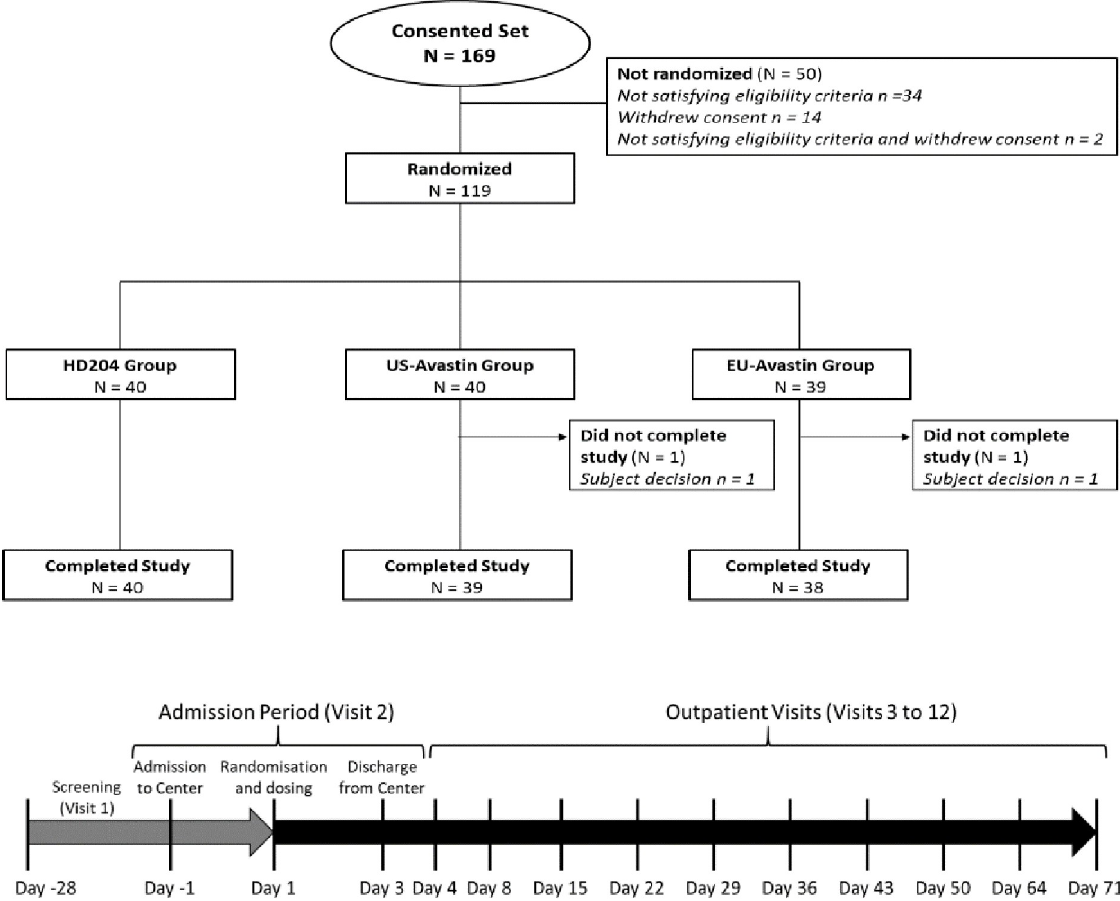
Fig 1. Study design. N = number of subjects. Pharmacokinetic schedule: Prior to infusion of study drug, 45 minutes after the start of study drug infusion, at the end of infusion, at 3h, 6h, and 12h after the end of infusion, at 24h (Day 2), 48h (Day 3), 72h (Day 4), 168h (Day 8), 336h (Day 15), 504h (Day 22), 672h (Day 29), 840h (Day 36), 1008h (Day 43), 1176h (Day 50), 1512h (Day 64), 1848h (Day 78) and 1680h (Day 71).